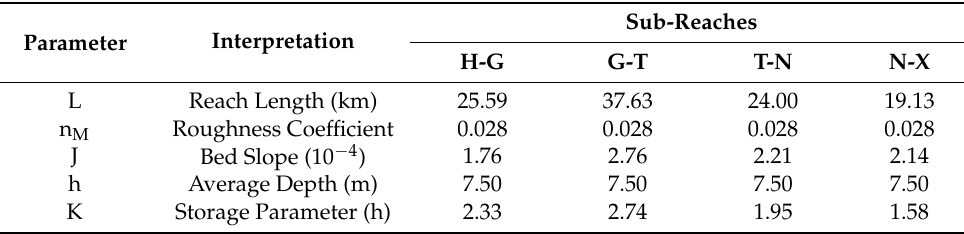
Table 2. Physical characteristics of river reaches in middle-Hanjiang River.